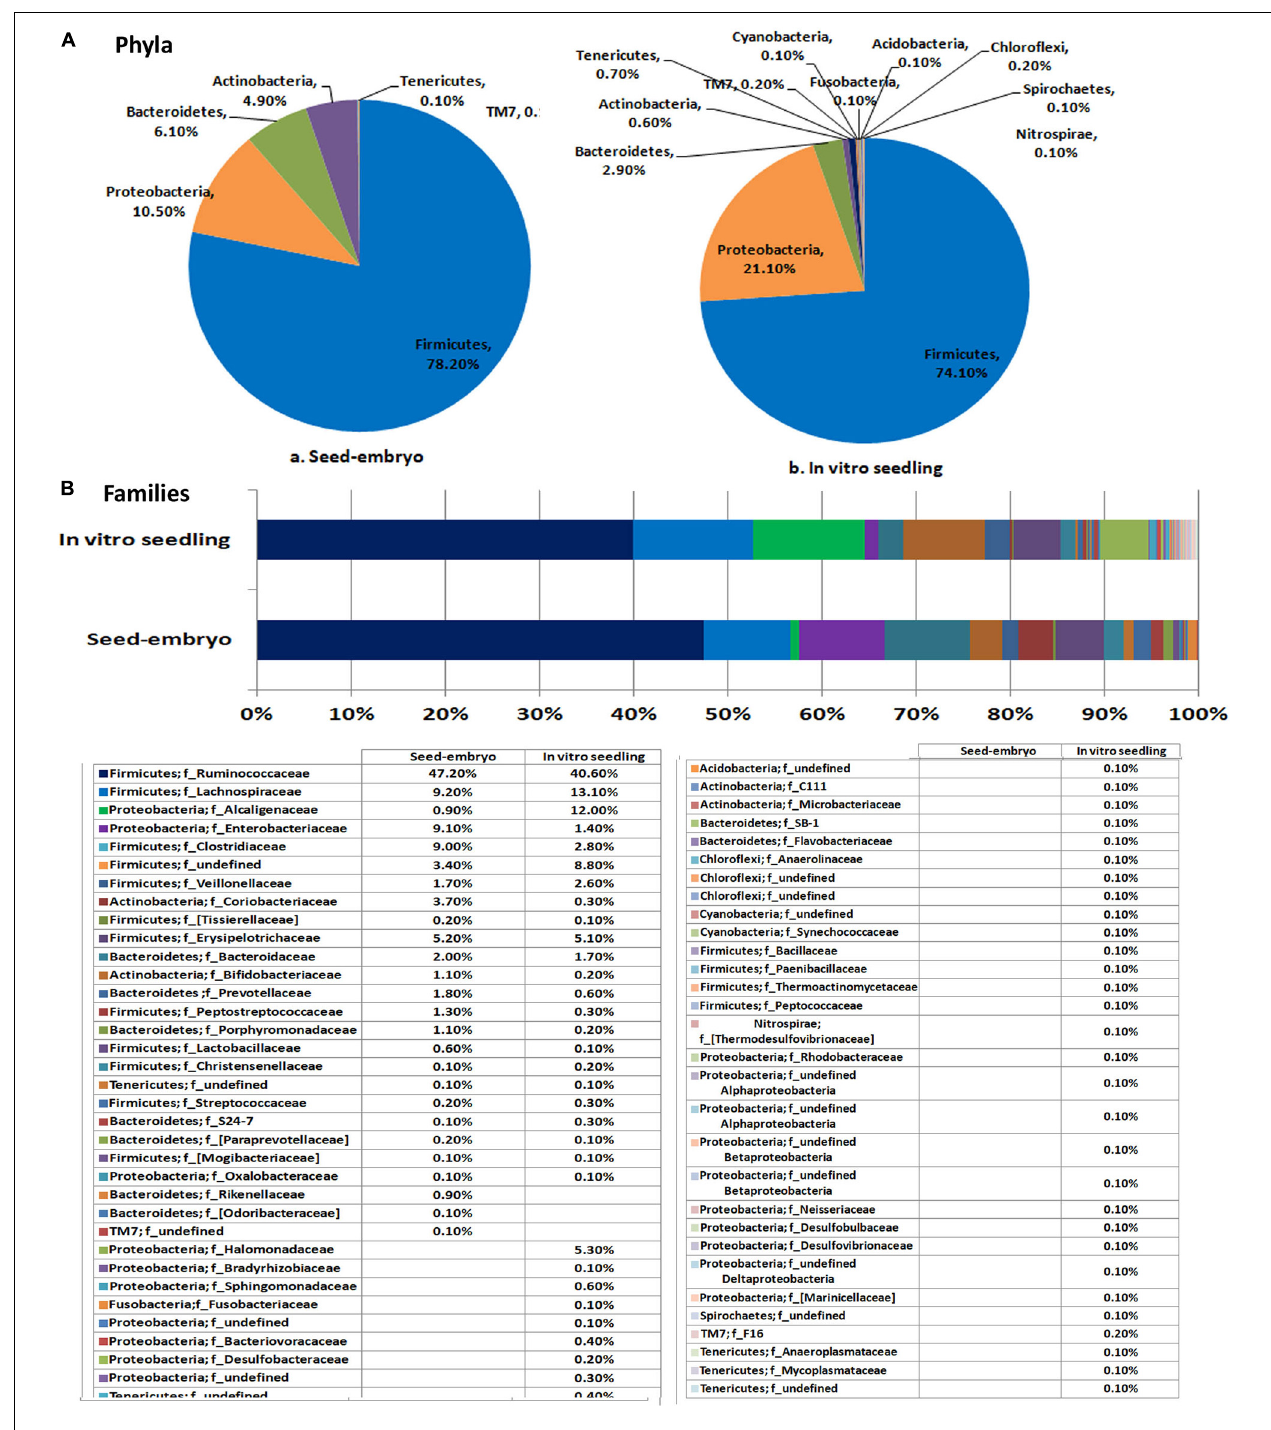
FIGURE 3 | Distribution of phylogenetic groups as per 16S rRNA metagene V3–V4 region taxonomic profiling of DNA derived from the seed embryo versus in vitro derived seedlings of watermelon cv. Arka Manik at phylum (A) and family (B)